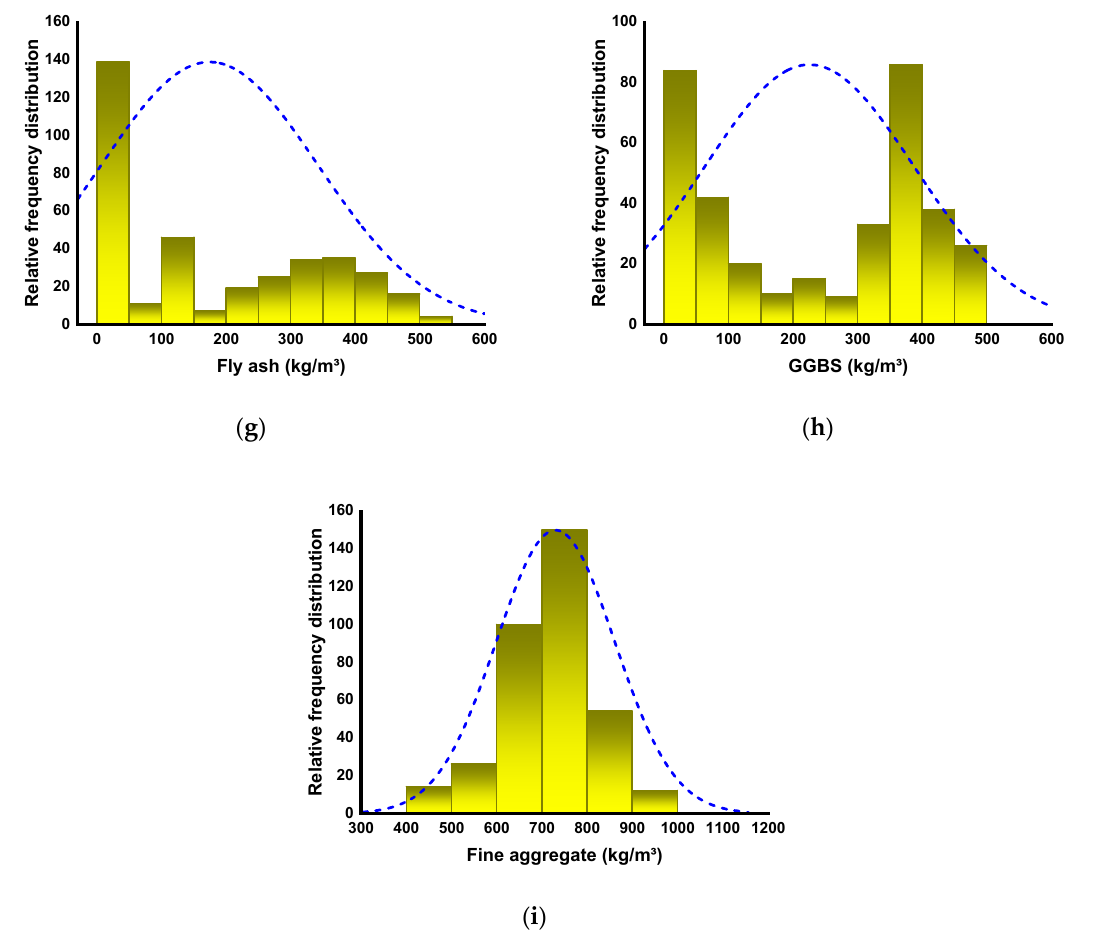
Figure 2. Relative frequency dispersal of inputs: ( a ) Water/solids ratio; ( b ) NaOH Molarity; ( c ) Gravel 4/10 mm; ( d ) Gravel 10/20 mm; ( e ) NaOH; ( f ) Na 2 SiO 3 ; ( g ) Fly ash; ( h ) GGBS; ( i ) Fine aggregate.